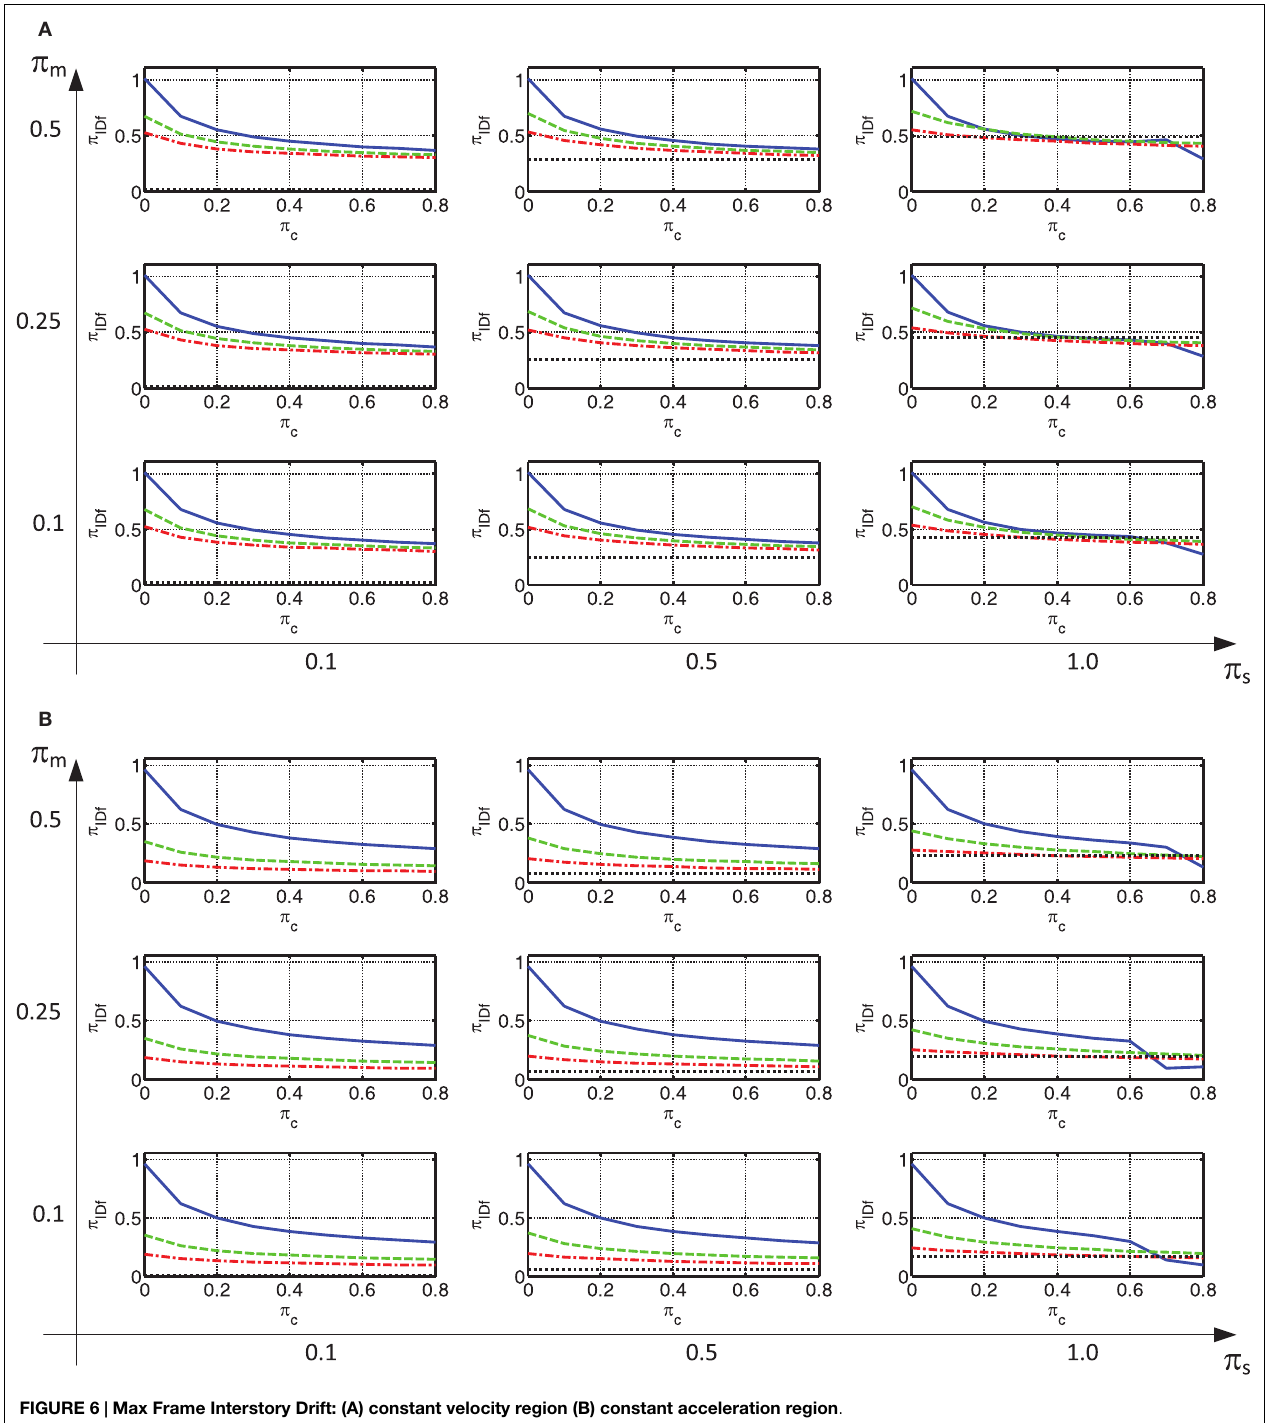
FIGURE 6 | Max Frame Interstory Drift: (A) constant velocity region (B) constant acceleration region .